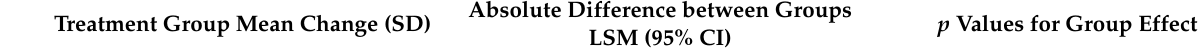
Table 2. Mean (SD) change in a anthropometric and clinical variables from WLM baseline to 12-month follow-up within each treatment group and least square mean (LSM) difference (95% CI) in change between treatments groups (Completed the six month Baseline, ITT/LOCF